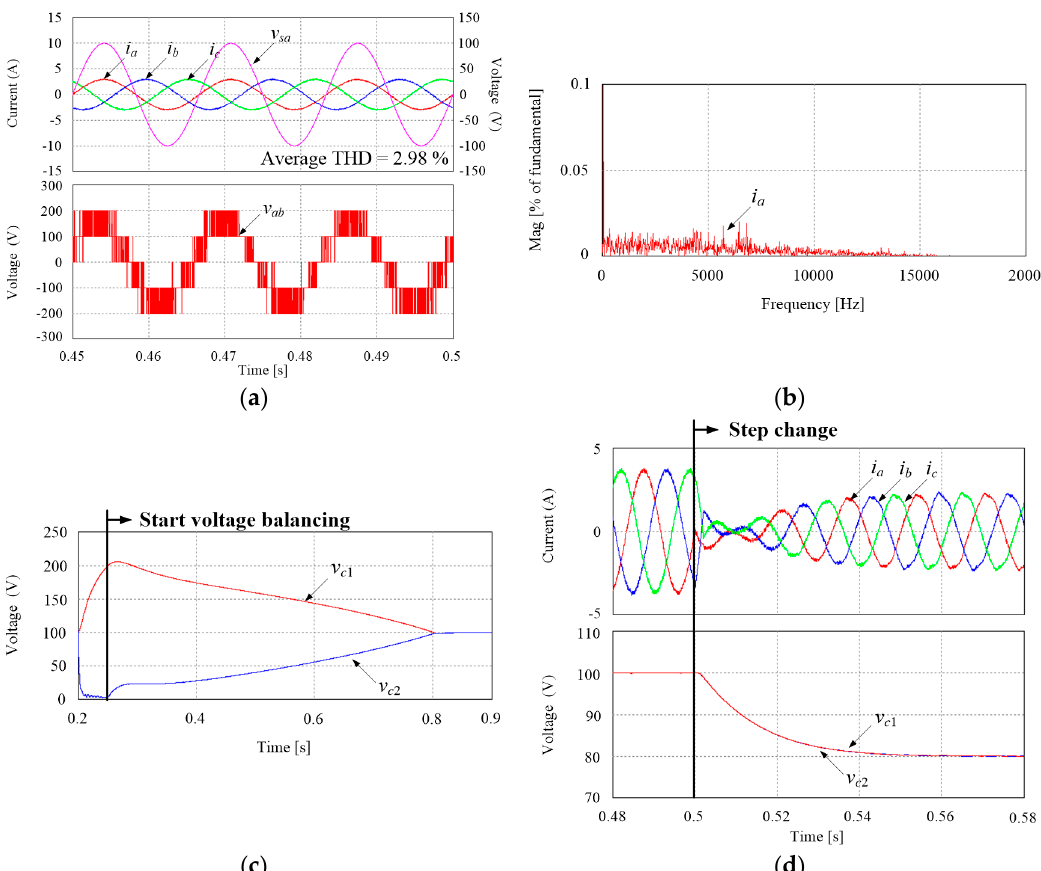
Figure 5. Simulation results of ( a ) three-phase input currents, a -phase input voltage, and line-to-line rectifier voltage ( b ) frequency spectrum of input current ( c ) capacitor voltages under conditions with intentional voltage unbalances ( d ) input currents and capacitor voltages with step change of output reference voltage from 200 to 160 V.